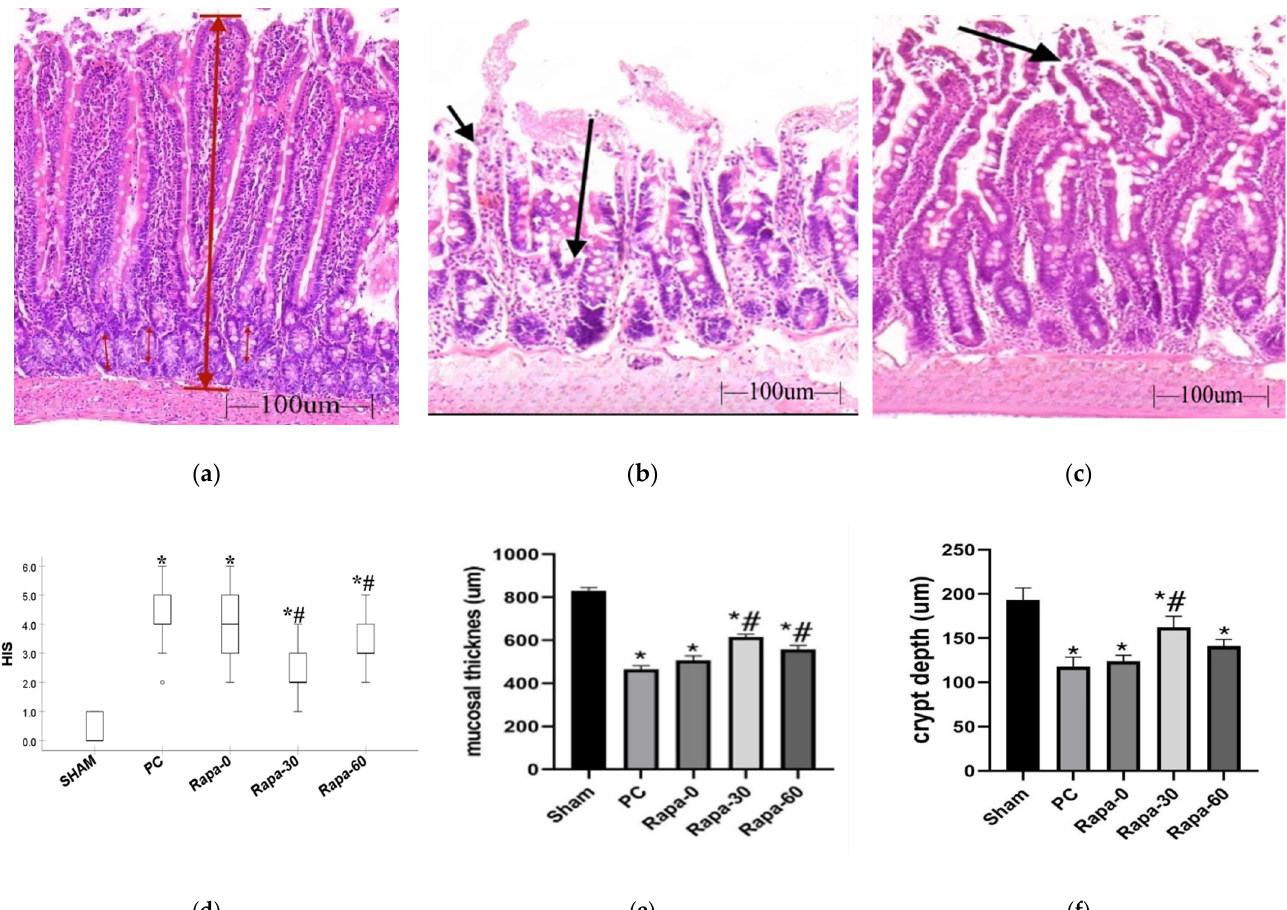
Figure 1. Histology and Morphometric measurements after cold preservation. ( a – c ) are representative images after HE staining for sham ( a ); PC ( b ) and Rapa-30 ( c ), respectively. ( a ) represents normal intestinal mucosa. This figure is annotated to illustrate how the mucosal thickness (thick, long red arrow) and crypt depth (thin, short red arrow) were measured in our samples. ( b ) shows severely damaged mucosa. Short arrow represents complete epithelial breakdown around villus, while long arrow represents total villus loss; both of which are characteristic for the PC group. ( c ) represents the characteristic intestinal injury in the Rapa ‐ 30 group. The arrow points to subepithelial space extending from the villus tip to the body of the villus. ( d ) is a representative dot plot for HIS scores of the various groups after preservation. n = 6. Data are shown as median (interquartile range); * p < 0.0001 vs. sham. # p < 0.05 versus PC group. ( e – f ) are graphical representation of mucosal thickness and crypt depth measurement respectively. n = 6. Data are mean ± SEM; * p < 0.05 vs. sham. # p < 0.05 versus PC group.